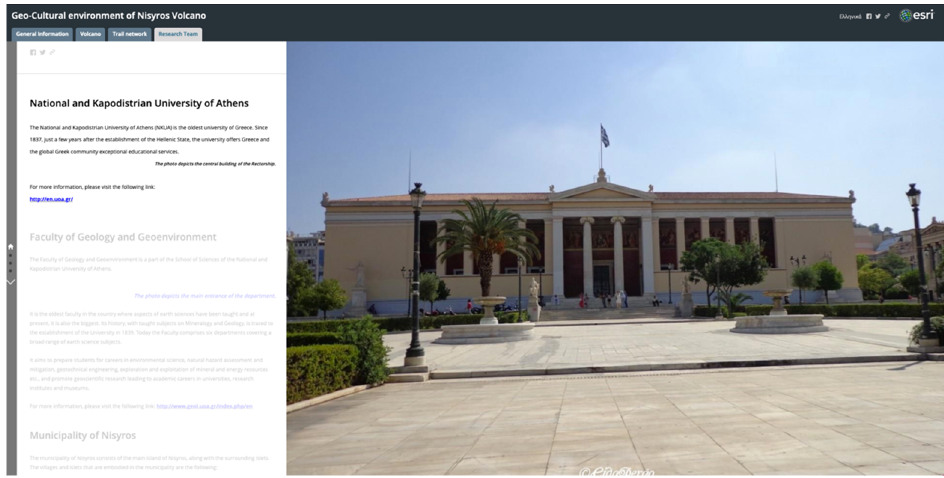
Figure 18. Screenshot showing part of the content of the last tab referring to the Research Team.